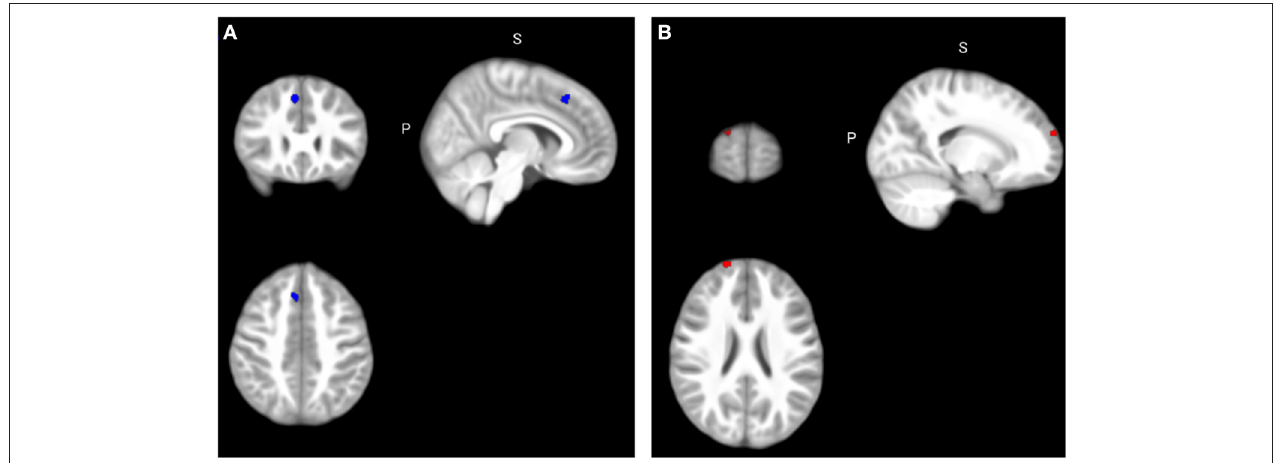
FIGURE 1 | Correlation between DCDQ-FC scores and regional grey matter volumes. (A) Significant negative correlation between the General Coordination score and GMV in the right medial frontal gyrus within the ASD group (x = 6, y = 27, z = 46) at p SVC − FWE < 0.004; (B) Significant negative correlation between the Total score and GMV in the right superior frontal gyrus within the ADHD group (x = 18, y = 68, z = 24) at p SVC − FWE < 0.05. FWE, Family-Wise Error.